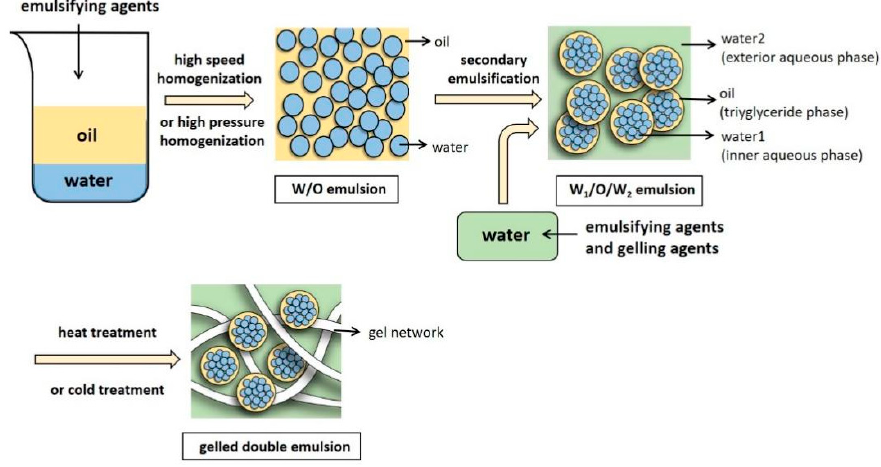
Figure 2. The preparation process of the W/O/W emulsion gel.